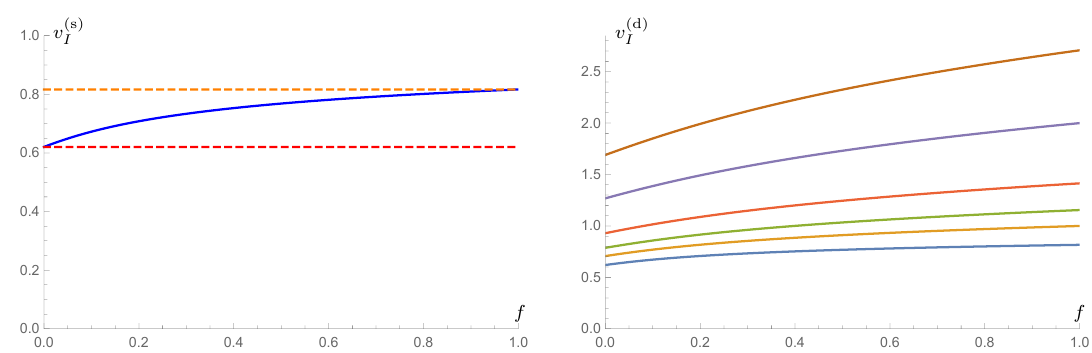
Figure 12 . Left: information velocity as a function of the entanglement fraction f for the standard strip. This reproduces the result for the commutative strip in figure 9. We also show the limiting values, v (s) ( f = 0) = v (s) and v (s) ( f = 1) = v (s) , depicted in red and orange, respectively. I E I B Right: information velocity for the dipole oriented strip as a function of f for various values of δ ∈ { 0 , 1 / 2 , 1 , 2 , 5 , 10 } , from bottom to top, respectively. This quantity behaves qualitatively the same as for the non-commutative strip, provided we identify the values of δ ↔ ϑ . However, there are very minor numerical differences for f < 1 which make the curves for the dipole case slightly more concave. For f = 1 they are exactly the same, because the functional dependence of v B with respect to δ or ϑ is the same for both